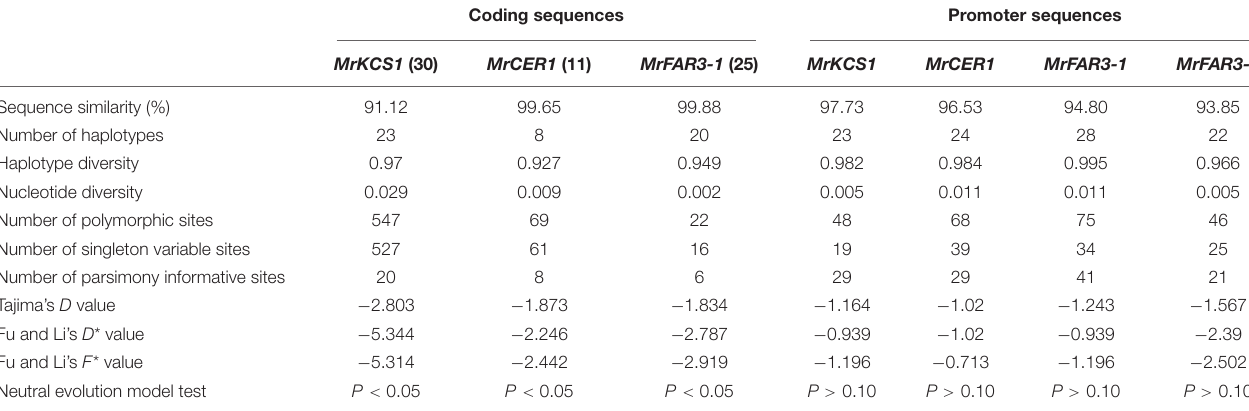
TABLE 2 | Genetic polymorphisms of the coding sequences and promoter sequences of the wax biosynthesis genes from 30 Medicago ruthenica